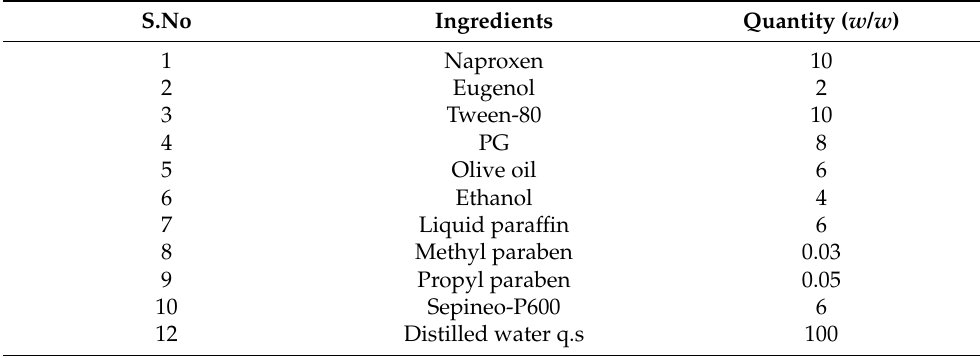
Table 10. Composition of optimized naproxen-eugenol emulsion formulations (100 g, w / w